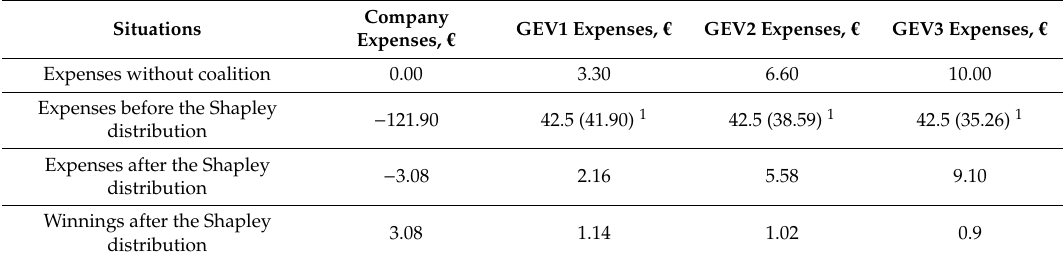
Table 2. Charge / discharge expenses of the coalition participants (players), applying the existing billing system.